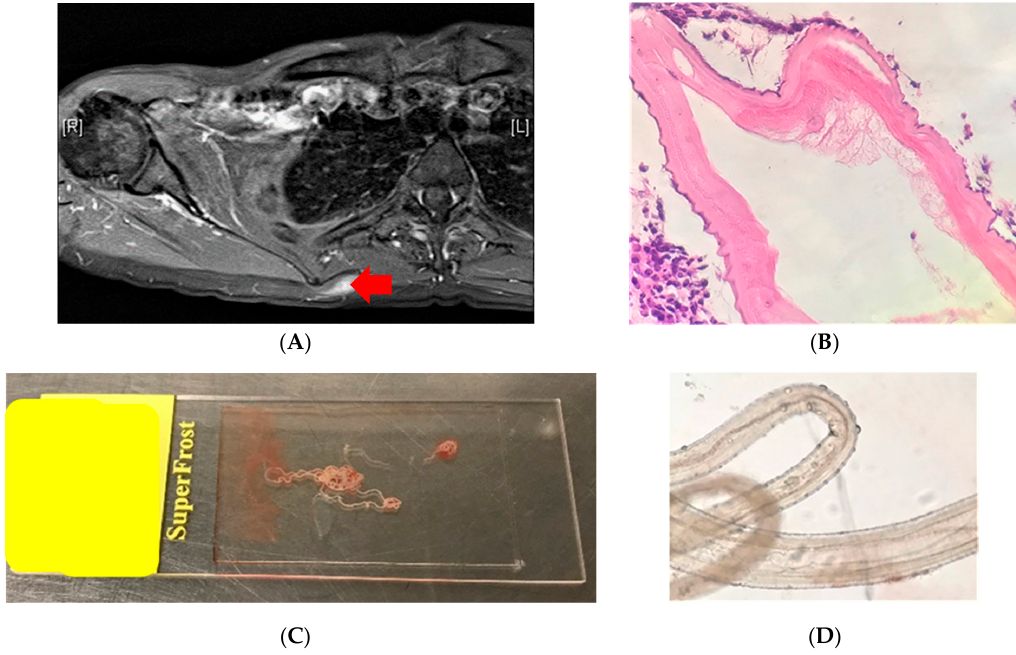
Figure 3. ( A ) PET/CT scan of back showing a lump in the back (red arrow). ( B ) Histology section of the biopsy showing a nematode helminth with features of a filarial worm. ( C ) Intertwined worm(s) fell out of the surgically removed lump. ( D ) On exam, these were found to be two, a thicker female and a thinner male.